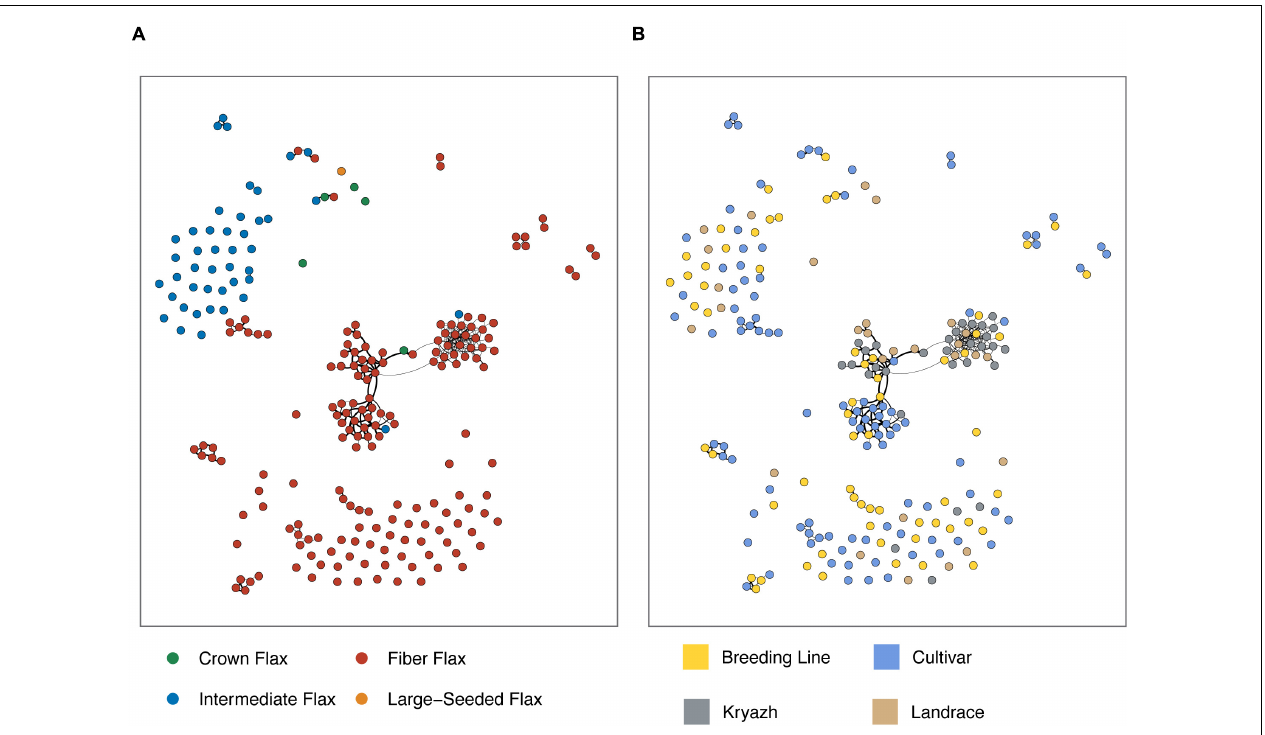
FIGURE 7 | Kinship graph constructed for selected flax samples (pi_hut threshold ≥ 0.5) using IBD. Nodes are flax accessions, while edges represent first-degree relations. Edges thickness reflects pairwise pi_hat values. Edges were further filtered to show those with pi_hat ≥ 0.7547 only (see the “Materials and Methods” section for details). (A) Node color corresponds to morphotypes. (B) Node color encodes breeding